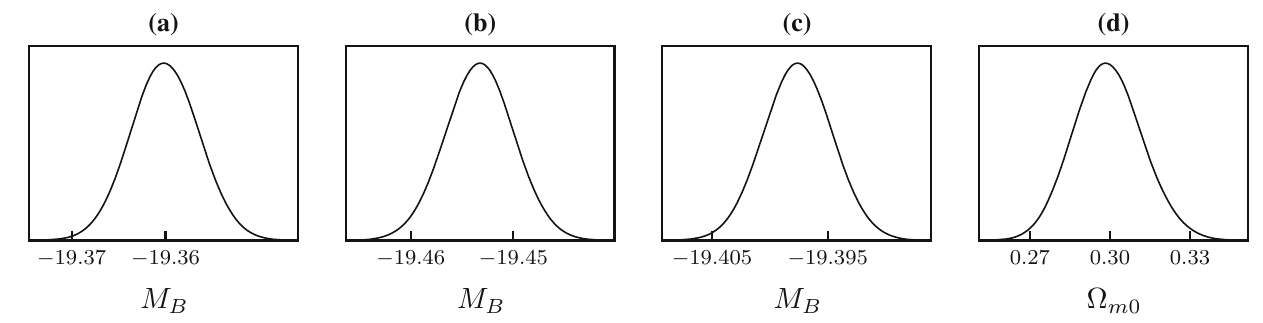
Fig. 2 Plots for marginalized likelihood of absolute magnitude M B for the Pantheon SN-Ia data using reconstructed H ( z ) from CC data ([ a ]), BAO data ([ b ]), and combined CC + BAO data ([ c ]). Plot for the marginalized matter density parameter (cid:12) m 0 ([ d ]) from the CMB Shift parameter data considering a fiducial (cid:2) CDM model